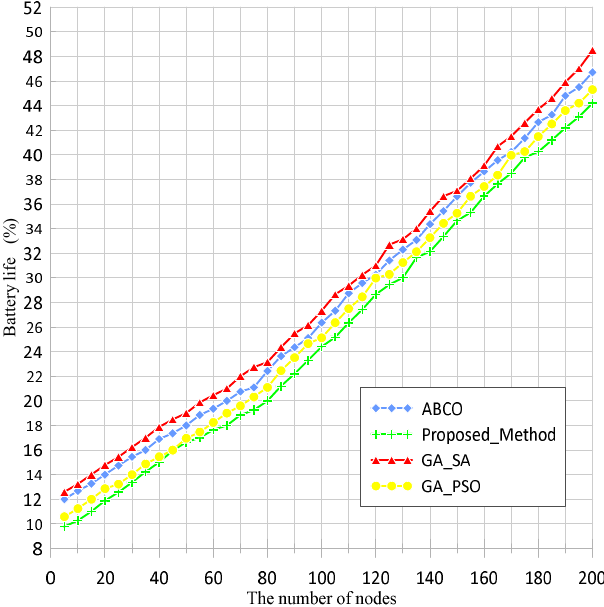
Figure 7. The battery life of the proposed method and three evolutionary algorithms.